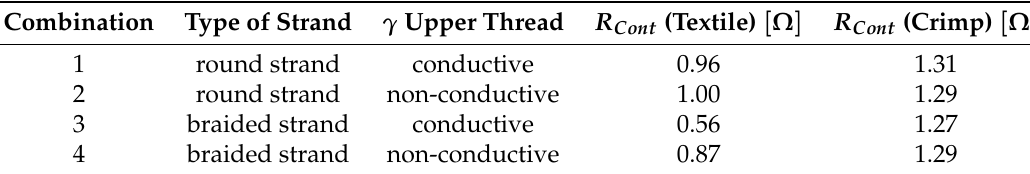
Table 2. Comparison of the contact resistances of textile contacting combinations with crimp contacting.